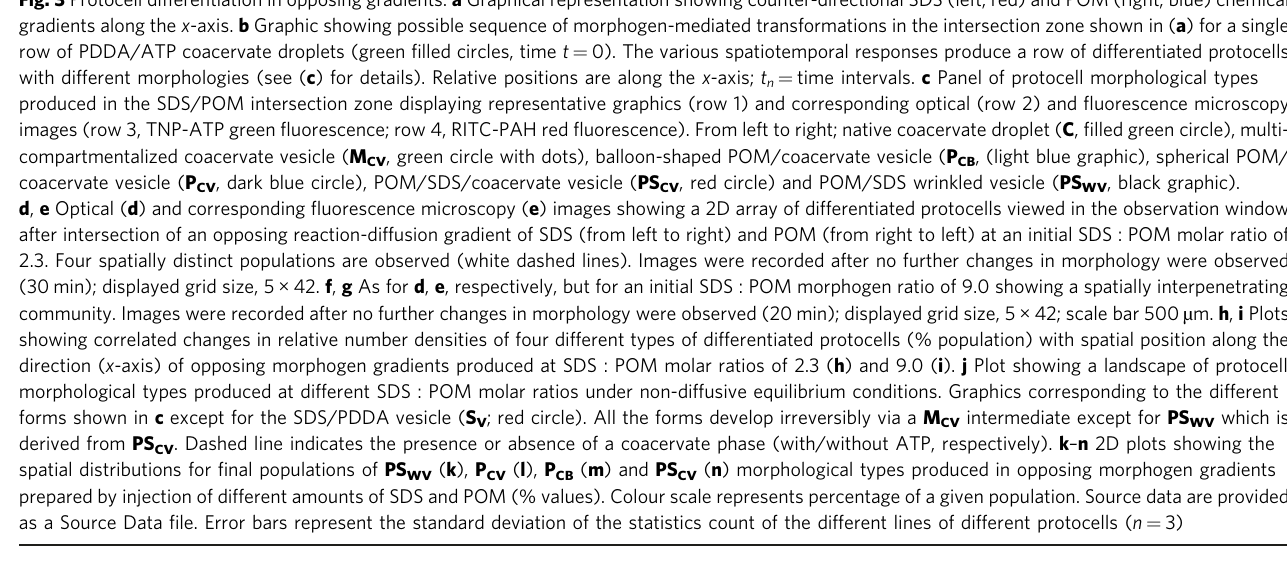
Fig. 3 Protocell differentiation in opposing gradients. a Graphical representation showing counter-directional SDS (left, red) and POM (right, blue) chemical gradients along the x -axis. b Graphic showing possible sequence of morphogen-mediated transformations in the intersection zone shown in ( a ) for a single row of PDDA/ATP coacervate droplets (green fi lled circles, time t = 0). The various spatiotemporal responses produce a row of differentiated